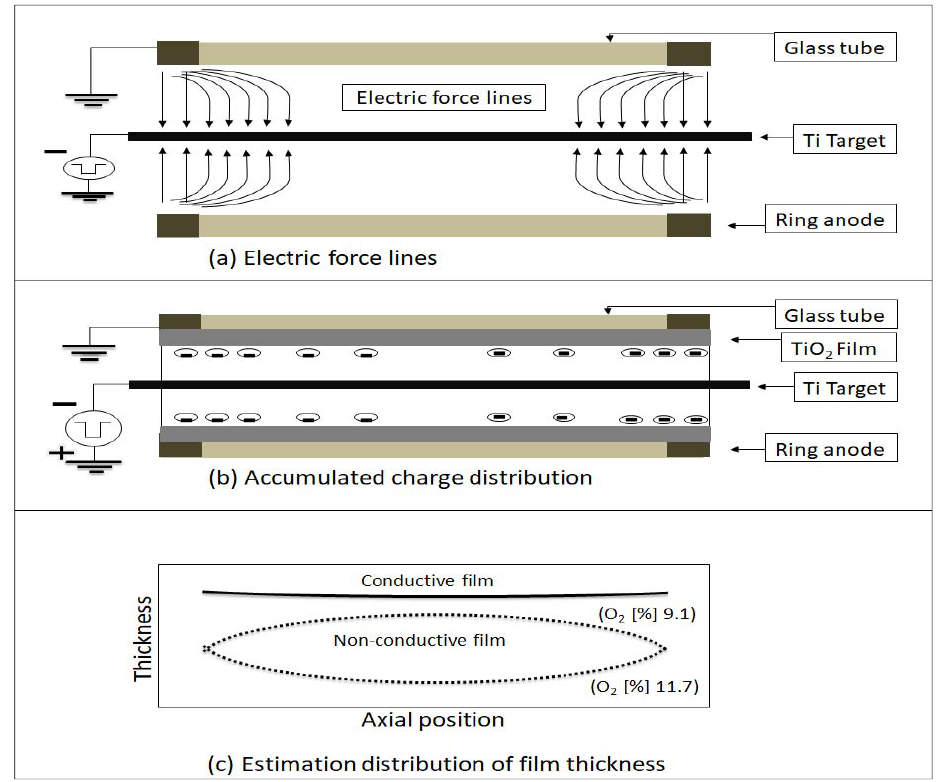
Figure 10. Schematic representation of the electric force lines, electric charges distribution, and estimation of the film thickness distribution in the case without using the Al outer anode. ( a ) A schematic representation of the electric force lines around the glass tube; ( b ) accumulated charge distribution around the glass tube; and ( c ) an estimation of the film thickness distribution in the case of a high resistance film.